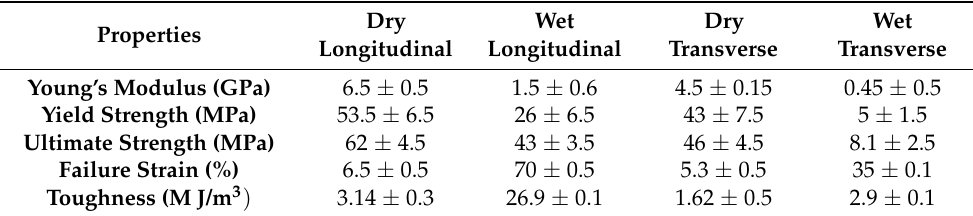
Table 3. Tensile properties of Deccani sheep horns. Properties